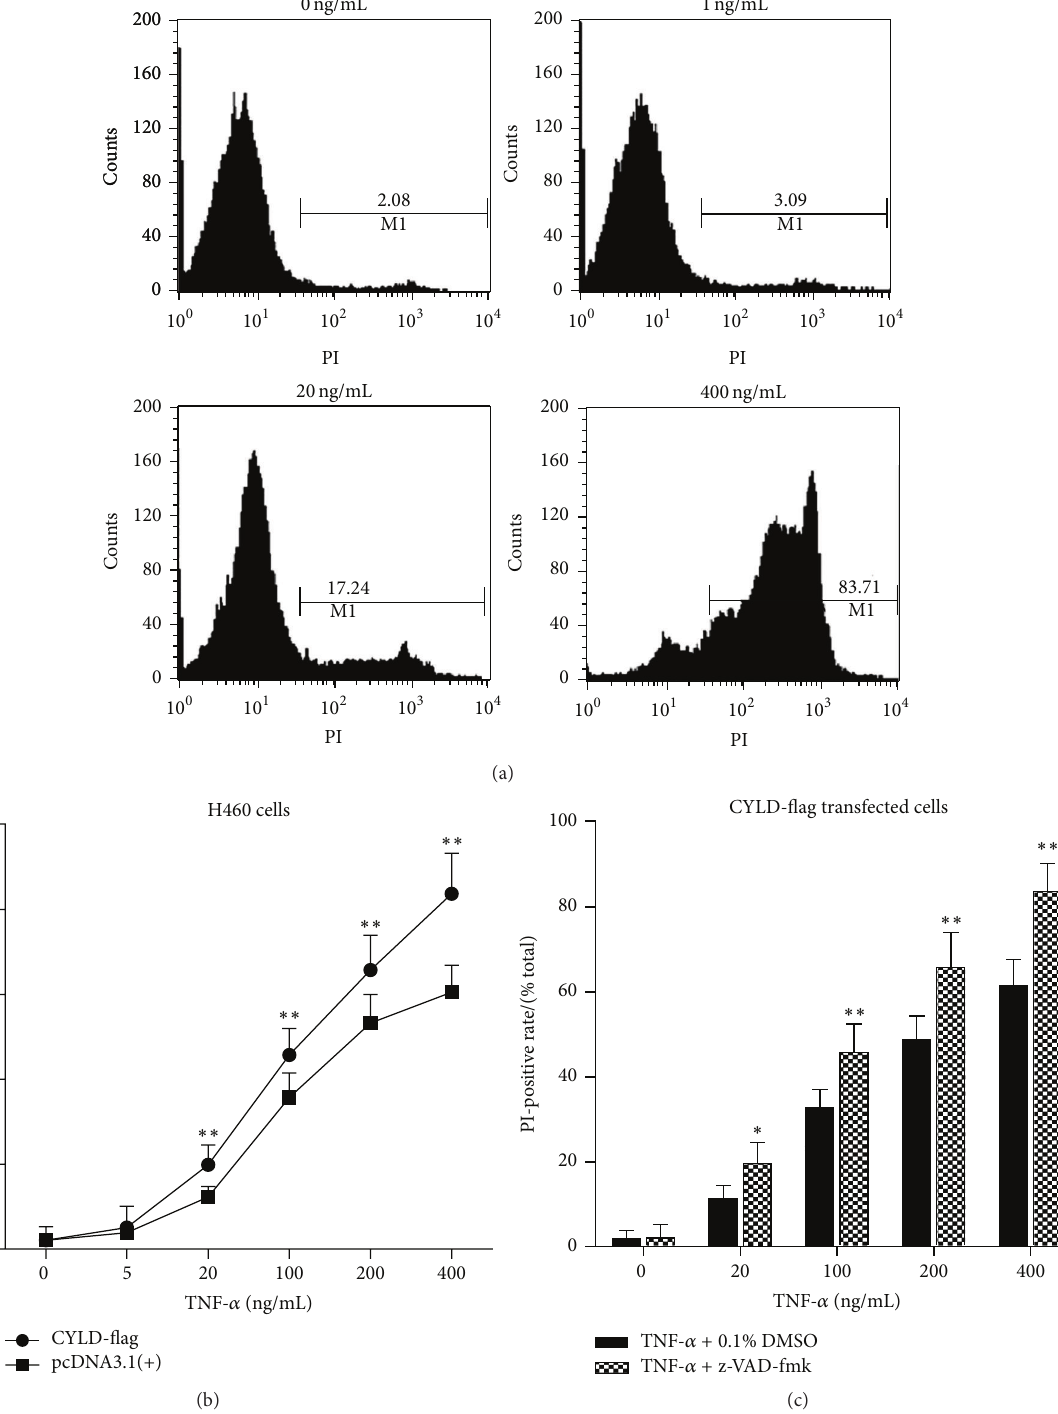
Figure 5: Overexpression of CYLD enhances TNF- 𝛼 -induced cell necrosis of lung cancer cells. (a) The necrosis was determined by FACS assay with PI staining. The CYLD-flag plasmid was used to transfect the lung cancer cell line H460 cells. The stable transfected cell line was screened as described in Material and Method. Increasing concentration of TNF- 𝛼 , including 0ng/mL, 1ng/mL, 20 ng/mL, and 400 ng/mL, respectively, was used to treat the CYLD-flag plasmid transfected H460 cells. (b) The PI-positive rates of CYLD-flag transfected H460 cells wereshowninhistogram. ∗∗ 𝑝 < 0.01 ,comparedwithpcDNA3.1(+)transfectedH460cells.(c)TheCYLD-flagtransfectedcellswerepretreated with a pancaspase inhibitor, z-VAD-fmk at the concentration of 10 𝜇 M for 6 hours, and different concentrations of TNF- 𝛼 were used to treat H460 to induce cell necrosis. The PI-positive rates of H460 cells were shown in histogram. ∗ 𝑝 < 0.05 , ∗∗ 𝑝 < 0.01 , compared with the group without